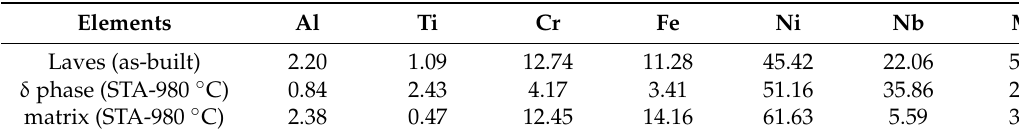
Figure 5. IPFs of ( a ) STA-980 °C, ( b ) STA-1045 °C, ( c ) STA-1065 °C, ( d ) STA-1120 °C, and ( e ) STA- 1180 °C/1 h specimens were analyzed using the orientation measurements by EBSD. The building directions are shown by arrows.